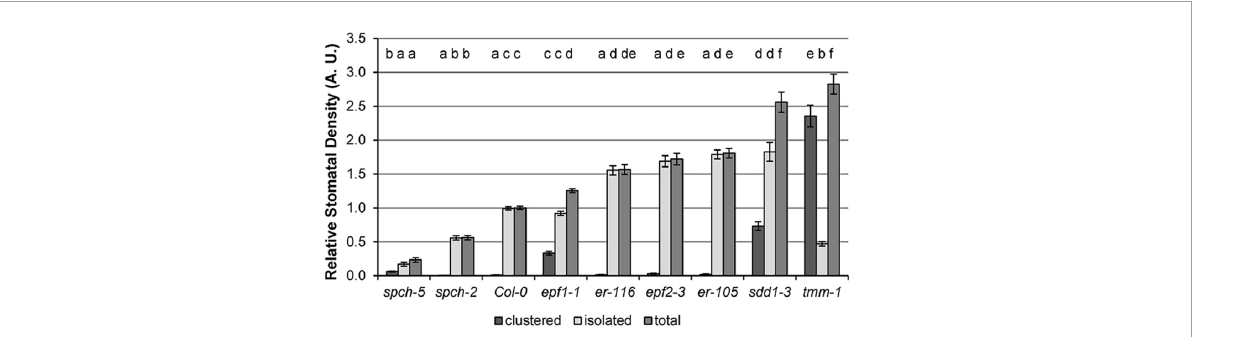
FIGURE1 Stomatal density in the abaxial cotyledon epidermis of Col-0 and stomata developmental mutants. Values are shown relative to Col-0, and error bars represent ± SE of the means. Incidence of single, clustered, and total stomata is depicted. Different letters above the bars indicate statistically significant differences between genotypes ( p ≤ 0.05) according to one-way ANOVA, followed by the Dunnet’s T3 test (isolated and total stomata data) or the Kruskal–Wallis test followed by the Dunn’s test (clustered stomata data). Data were obtained from fully expanded cotyledons (23 dag) of 10 plants ( n =